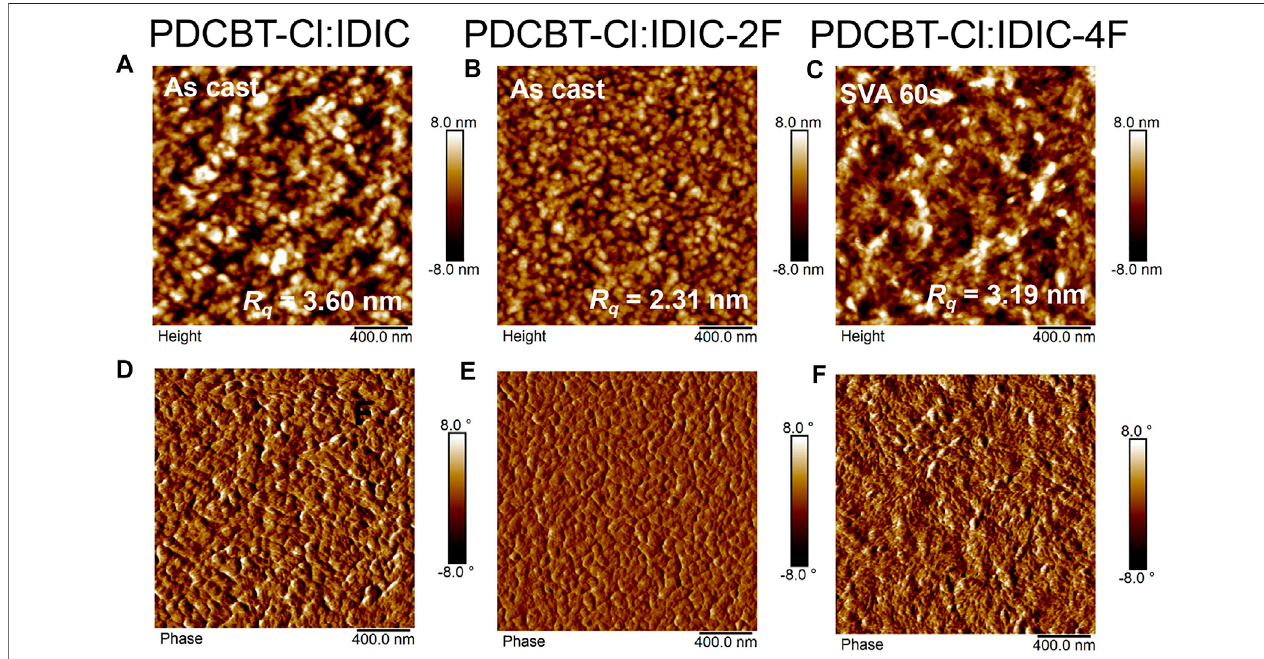
FIGURE 5 | AFM height images (A – C) and phase images (D – F) for PDCBT-Cl:IDIC (A,D) , PDCBT-Cl:IDIC-2F (B,E) and PDCBT-Cl:IDIC-4F (C,F) -based blends under the optimized